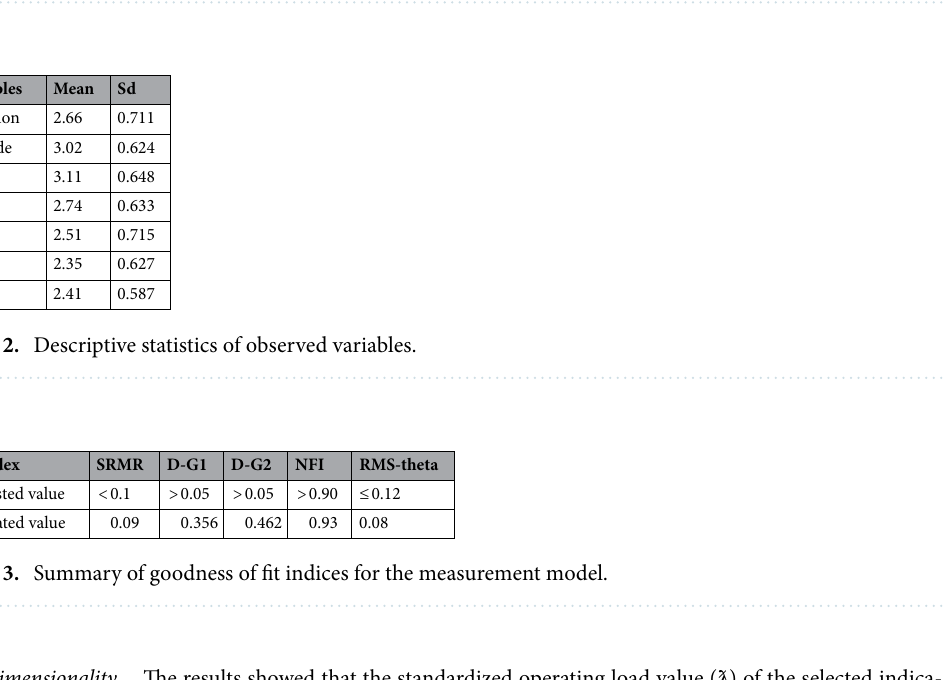
Table 1. Demographic characteristics of farmers.